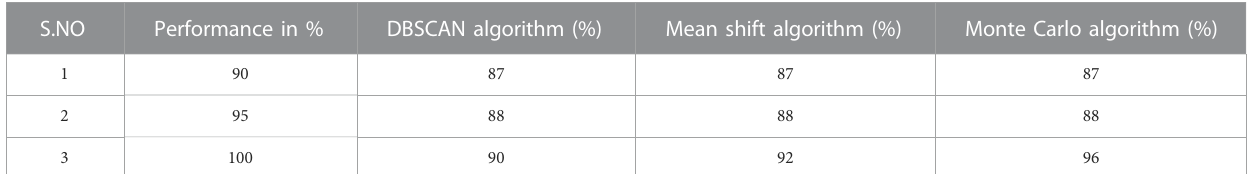
TABLE 1 Comparison of DBSCAN, mean shift and Monte Carlo